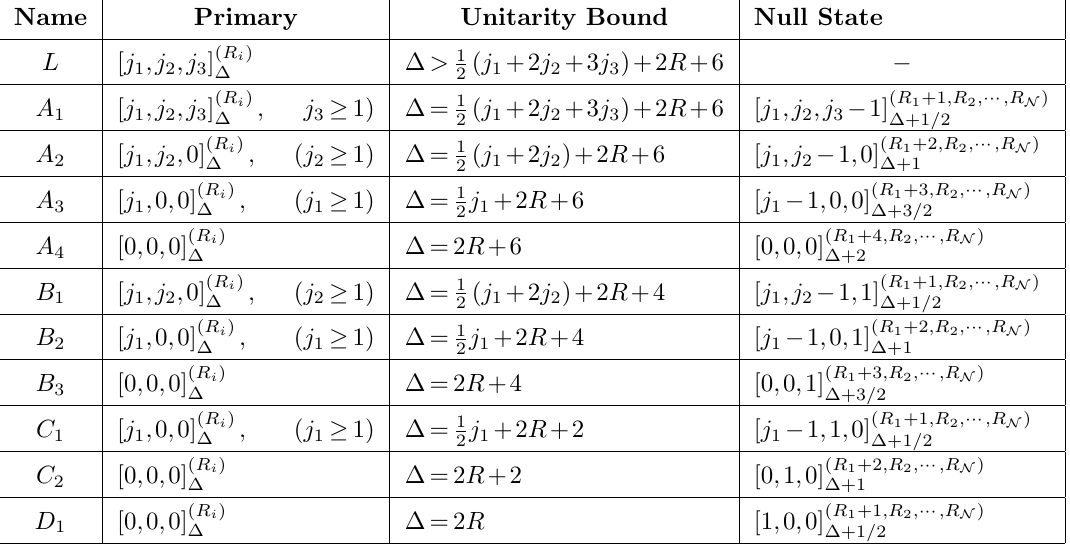
Table 32 . Unitary representations of the 6 d superconformal